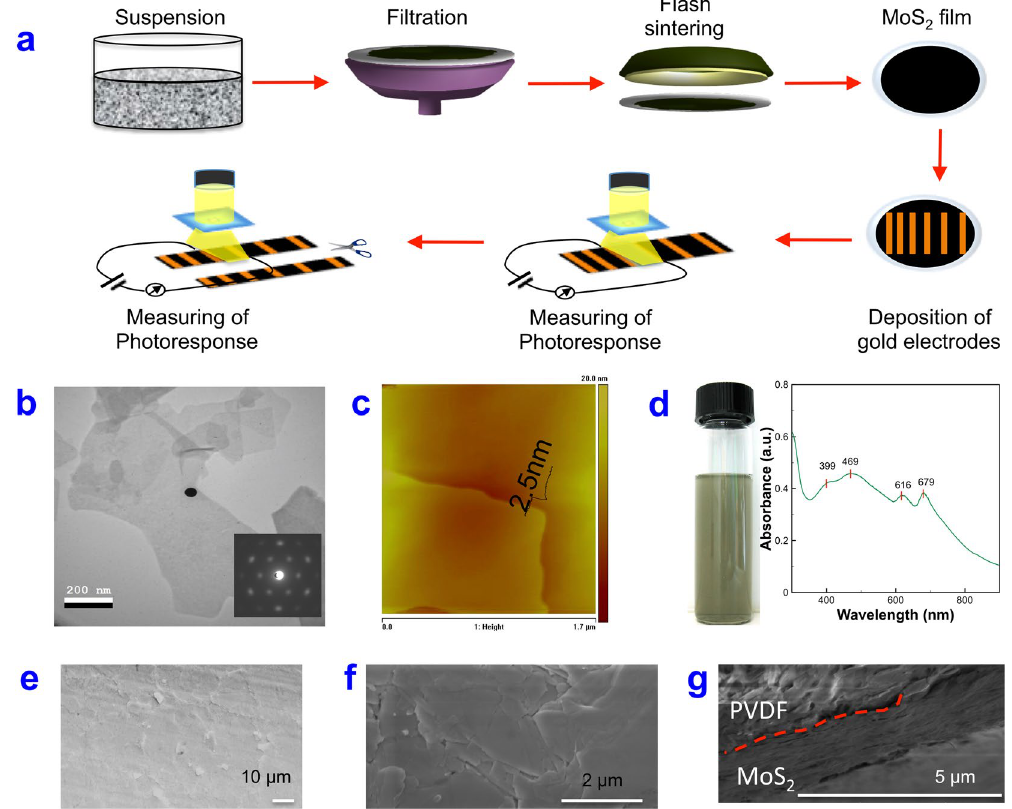
Figure 1. ( a ) Schematic drawing of experimental procedures. MoS 2 was first exfoliated in a pH 1.0 nitric acid solution and then collected on a PVDF membrane by filtration, followed by flash-light processing and polishing. Gold electrodes with a designed pattern were then deposited onto the film, and the photoresponse was measured under illumination. ( b ) TEM image of exfoliated MoS2 sheets. The insert is the electron diffraction pattern of the flake. ( c ) AFM image of MoS 2 sheets, ( d ) A photograph of exfoliated MoS 2 after two months of settling and the UV/Vis absorbance of exfoliated MoS 2 in water. Low ( e ) and high ( f ) magnification SEM images of MoS 2 film deposited onto a PVDF membrane after flash-light processing and polishing. ( g ) Cross-section SEM image of MoS 2